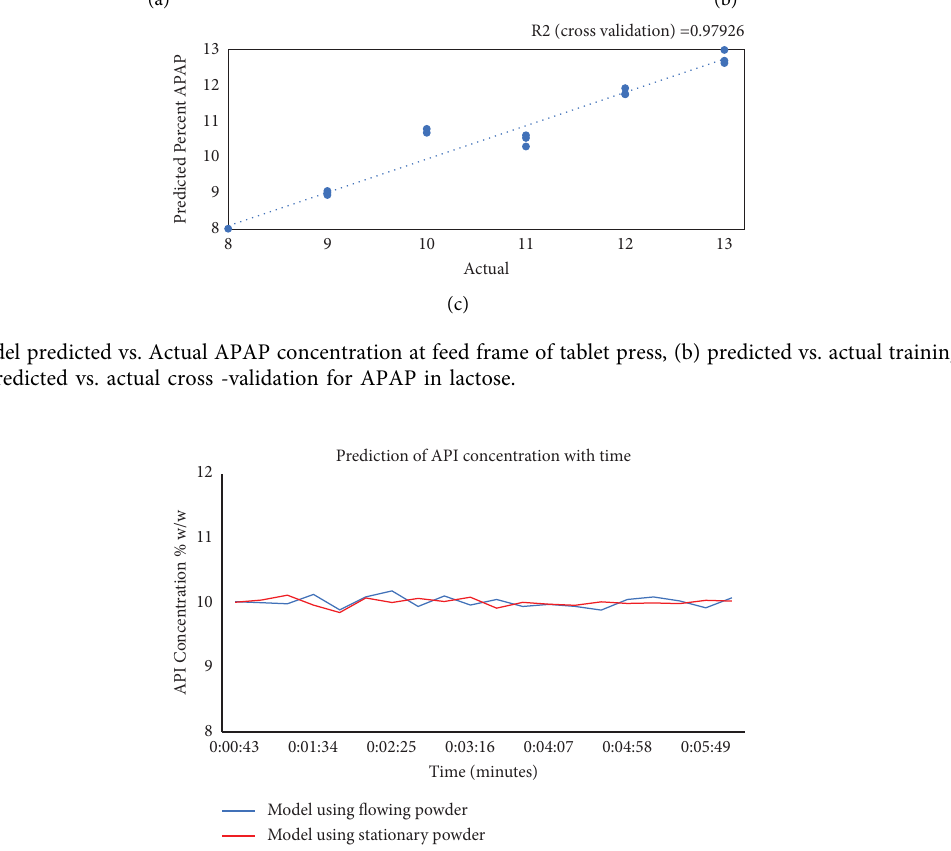
Figure 9: Prediction of API concentration using the model that uses stationary powder data and model that uses fowing powder data against the known concentration of 10% w/w APAP in